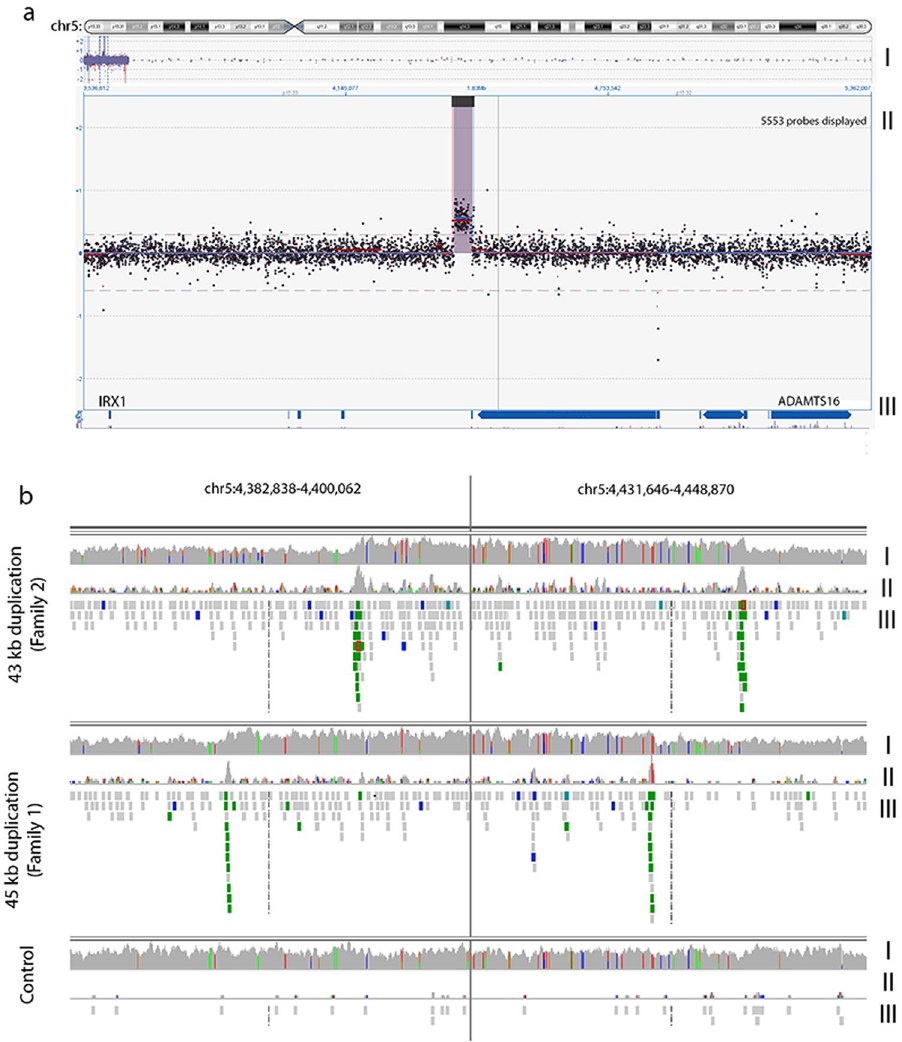
Figure 2. NCMD is caused by intergenic duplication events located between IRX1 and ADAMTS16 . ( a ) aCGH experiment (10,000 probes spanning the MCDR3 locus at GRCh37/hg19 chr5:11882-10140073, panel I) performed in three affected individuals from families 1–3 that were found to harbour heterozygous duplications of approximately 43 kb (panel II) located in a gene desert downstream of IRX1 and upstream of ADAMTS16 (panel III), also confirmed by WGS ( b ) by changes in coverage from concordant and discordant reads (panel I and II, respectively) and identification of chimeric reads, pair-reads with opposing orientation (displayed in green, panel III). Panels are presented with a split view option within IGV. The duplications are located in the overlapping regions GRCh37/hg19 chr5:4391880–4434888 (family 1) and GRCh37/hg19 chr5:4397221– 4440150 (families 2 and